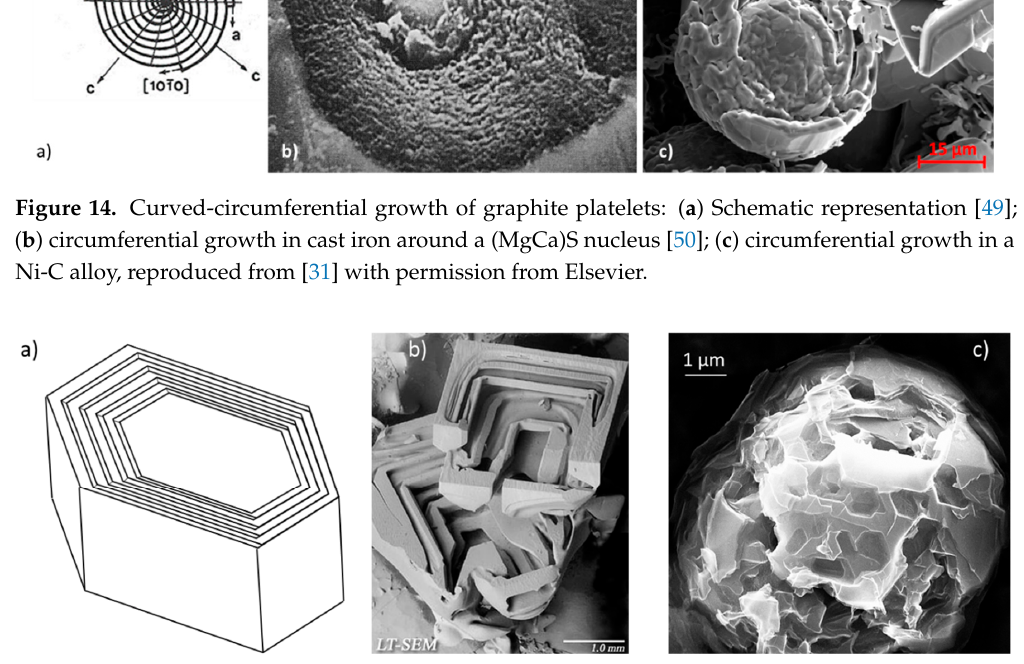
Figure 15. Hopper-skeletal crystal growth: ( a ) Schematic representation; ( b ) hopper crystal in ice; ( c ) quasi-spheroidal graphite hopper crystal in heat-treated cast iron.